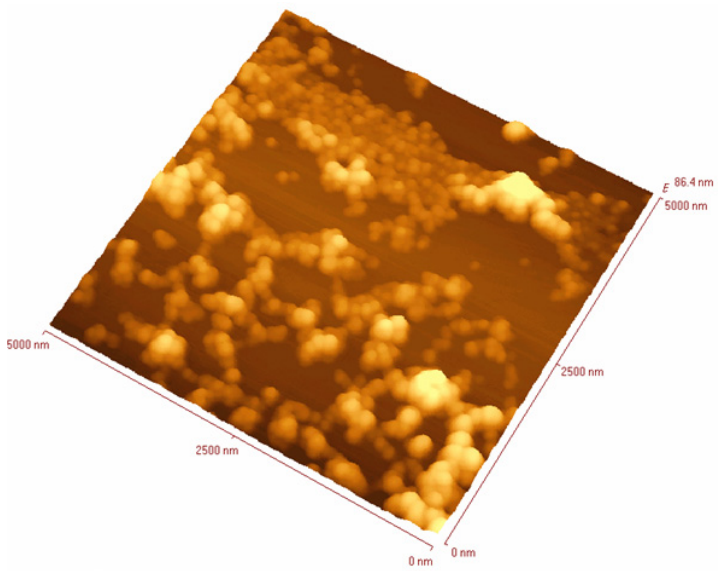
Figure 39. Non-contact mode AFM image of L -RA-Pro-based SLNs spread on a freshly cleaned glass slide [120].